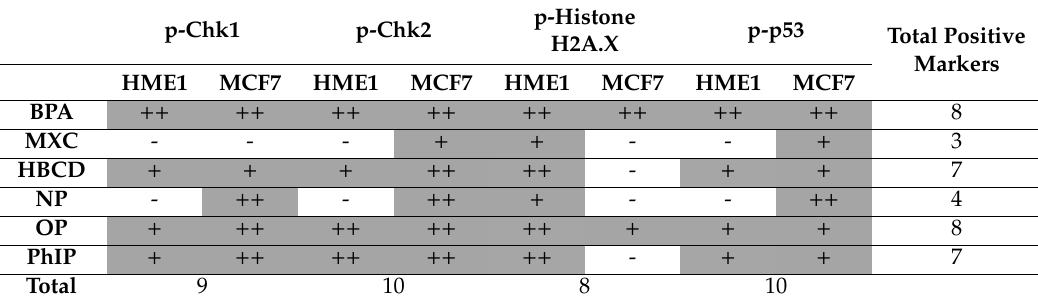
Table 1. Induction of DNA damage markers by environmental contaminants.